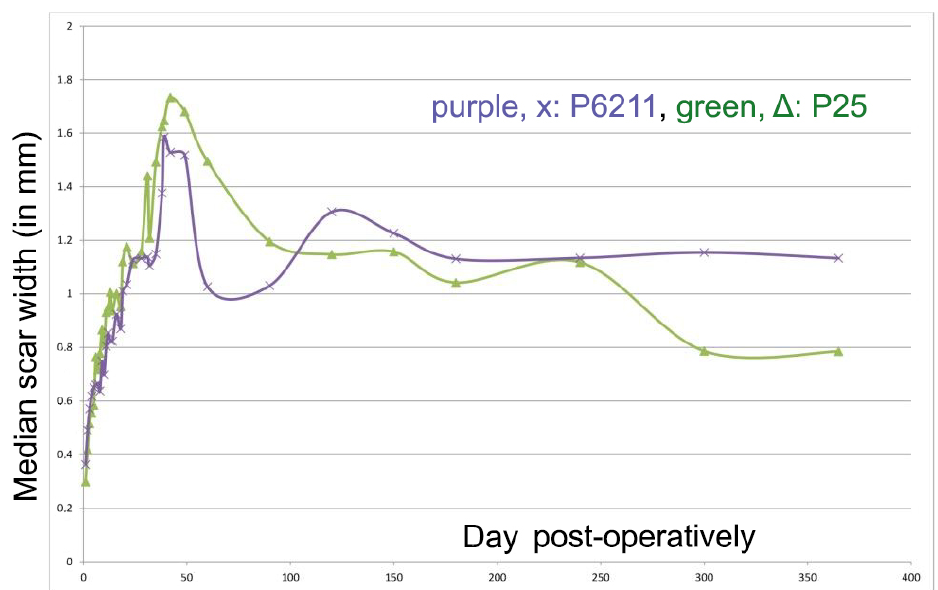
Figure 3. Median scar width (mm) for each suturing material (purple: P6211; green: P25) during the study.